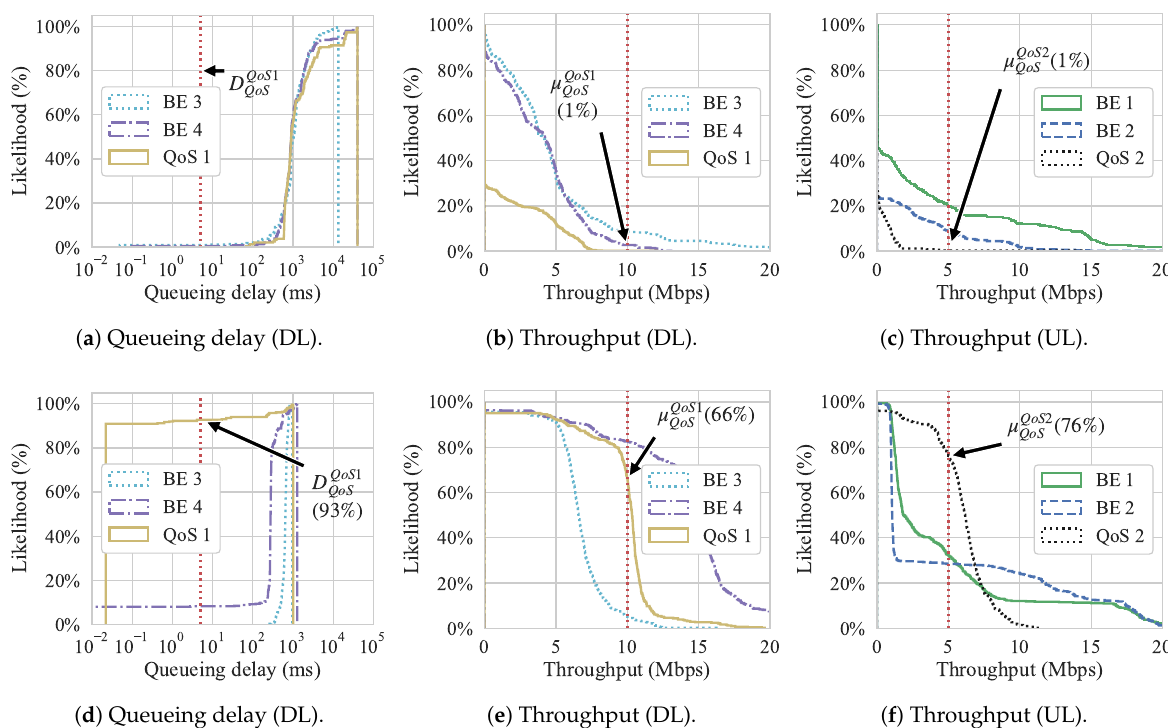
Figure 16. Experiment 3 CDFs. ( a ) Queueing delay of slices (DL), ( b ) throughput of slices (DL), and ( c ) throughput of flows from STAs (UL) with Gómez et al. [5]; ( d ) queueing delay of slices (DL), ( e ) throughput of slices (DL), and ( f ) throughput of flows from STAs (UL) with our approach.